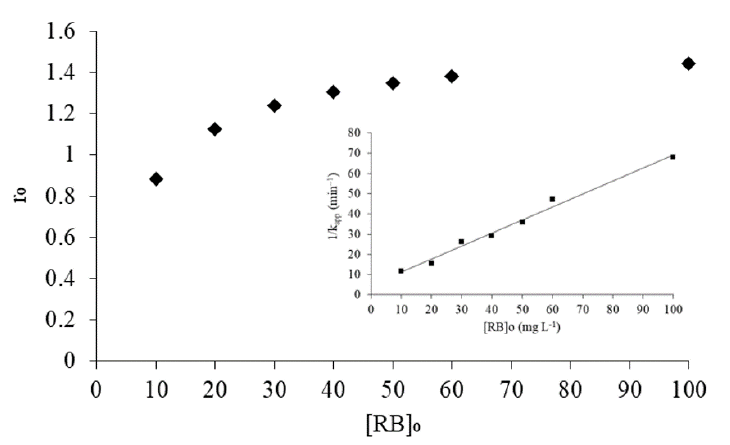
Figure 12. Effect of RB5 concentration on the initial rate of decolorization: Inset- Plot of reciprocal of apparent rate (K app ).